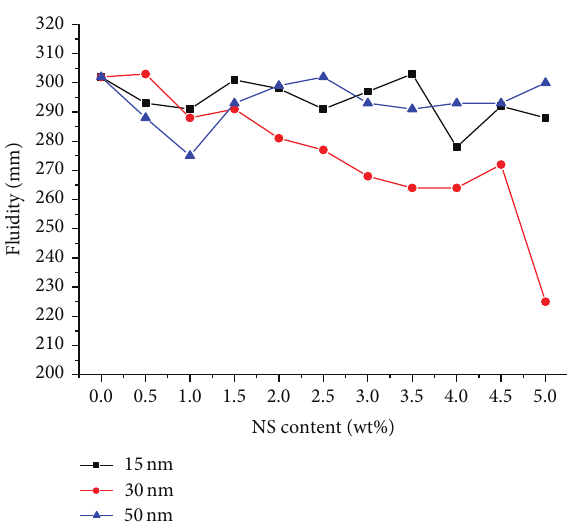
Figure 9: Variation in setting time (initial and final) on the mortar with the NS particle size. Figure 10: Variation in fluidity on the mortar with the NS content and NS particle